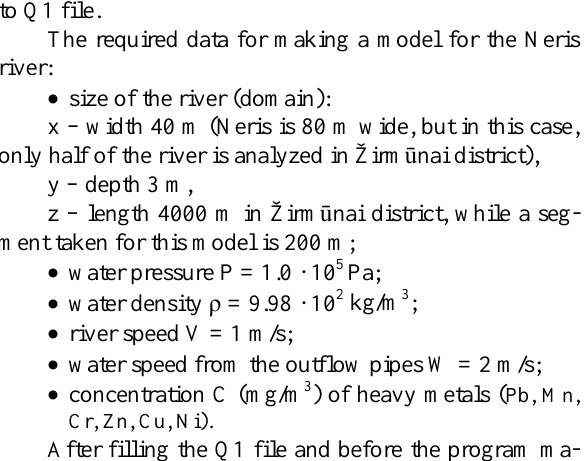
Fig. 6 . Heavy metals spread from outflow with maximum concentration: a – river surface, b – river